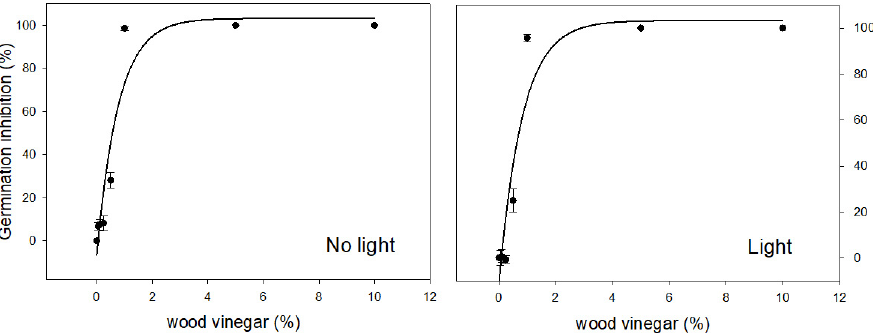
Figure 5. Impact of light and wood vinegar concentrations on common purslane seed germination.